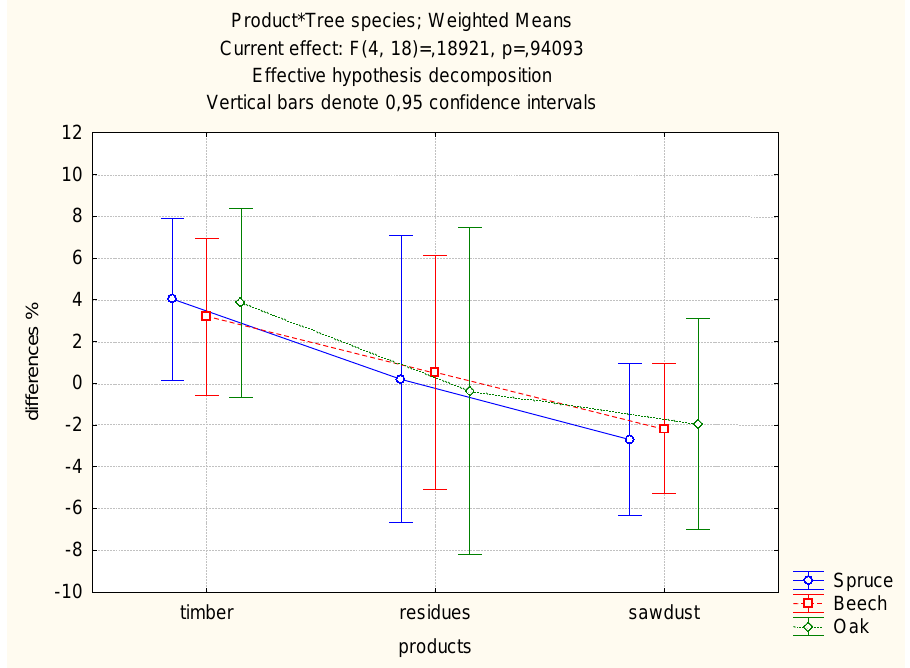
Figure 18. Average values of the differences in the measured and calculated values for the products of the individual tree species.